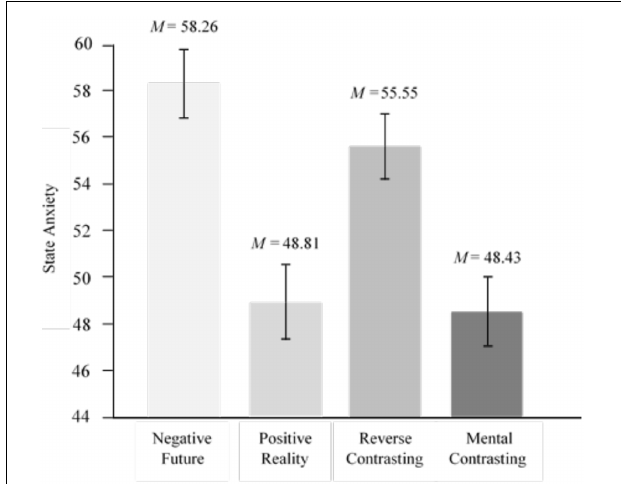
FIGURE 2 | Effects of self-regulatory strategies on state anxiety vis-à-vis an idiosyncratic feared future. Error bars represent standard errors. Covariates appearing in the model are evaluated at the following values: Trait anxiety, M = 38.98; baseline state anxiety, M = 8.32; expectations, M = 4.59; and incentive value, M =